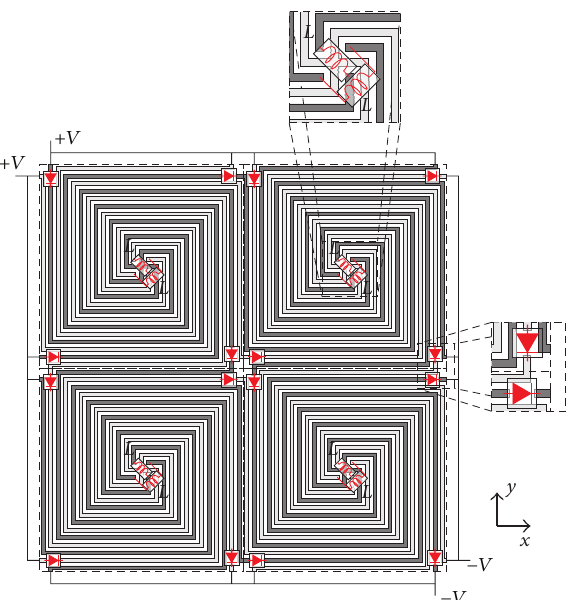
Figure 8: Layout of 2 × 2 array portion of sample free-standing bistate interwoven 7-fold quadrifilar spiral elements. The reference basic spirals in adjacent unit cells are alternatively marked dark and light grey to highlight the intertwining scheme. Four pin diodes are connected across breaks in the outer folds of the spiral conductors and the RF choke inductances are placed at the centre of each unit cellbetweentheopenendsofthespiralarmsextendedfromadjacent unit cells. Geometrical parameters of the unit cell: lattice period 𝑝 = 10.2 mm, spiral pitch 1.6mm, and strip width 𝑠 = 0.2 mm and thickness 17.5 𝜇 m.